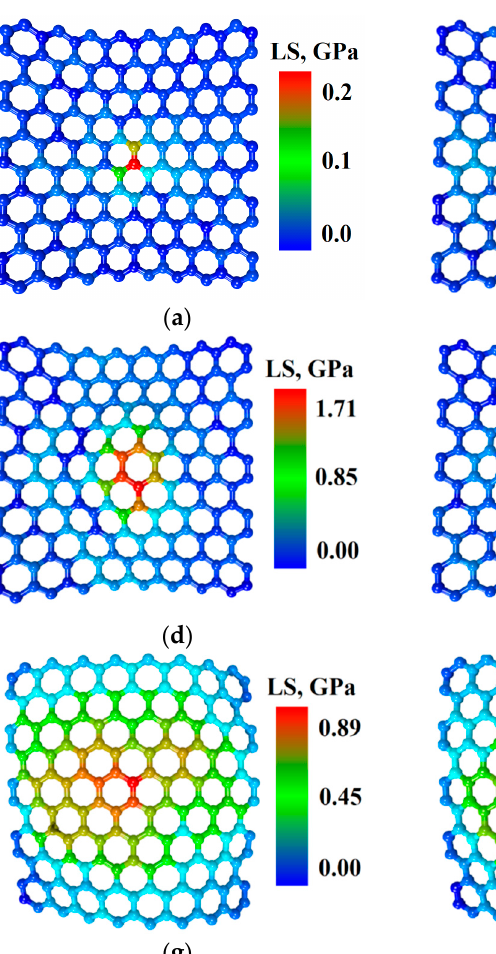
Figure 3. The map of the local stress (LS) in the central area of the graphene sheets at the key points of indentation: ( a ) point A; ( b ) point B (upper layer); ( c ) point C (upper layer); ( d ) point D (upper layer); ( e ) point E (upper layer); ( f ) point F (upper layer); ( g ) point G (lower layer); ( h ) point H (lower layer); and ( i ) the dependence of the maximum local stress (MLS) in graphene sheet atoms on the indentation step (the solid line corresponds to the forward stroke and the dotted line corresponds to the reverse).